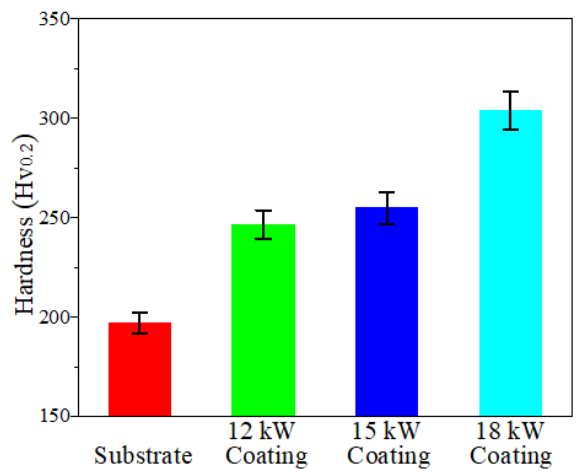
Figure 8. Surface hardness of slipper substrate and coatings under different spraying powers.